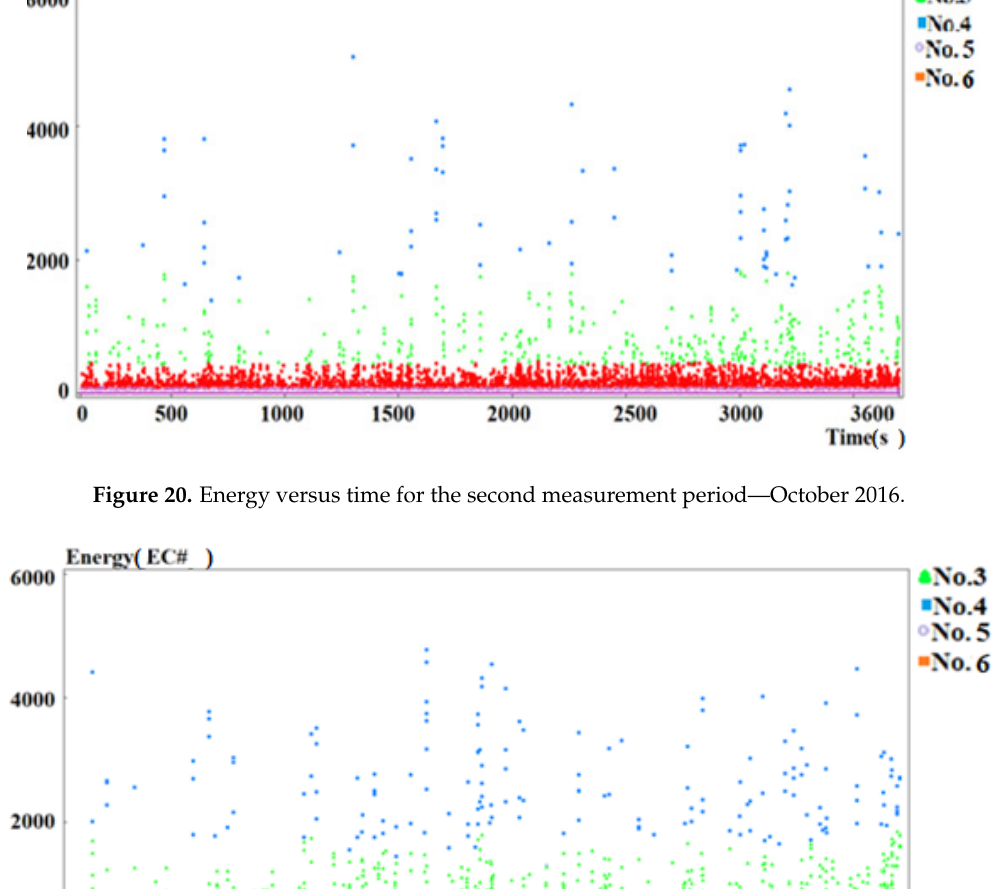
Figure 22. Signal duration versus time for three measurements. 4. Conclusions The examples of acoustic emission evaluation of various types of engineering structures and the proposed global monitoring system based on the measurement of acoustic emission signals accompanying destructive processes, covers the entire volume of the element under test or its selected part, and allows locating and identifying active destructive processes and their dynamics in real time. The data collected can be the basis for determining the structural condition of the structure [33–39]. The system is a useful tool for: 